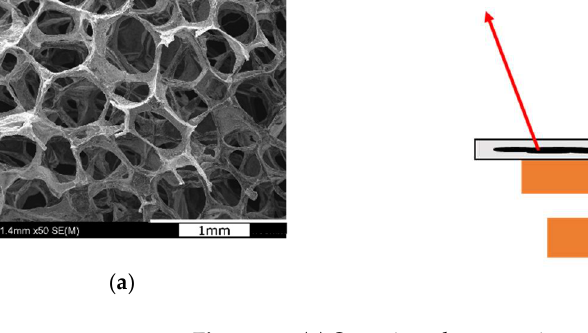
Figure 10. ( a ) Scanning electron microscope (SEM) image of the 3D rGO structure. ( b ) Illustration showing the collapse of the 3D rGO of the sensor under high pressure, acting as quasi-bulk